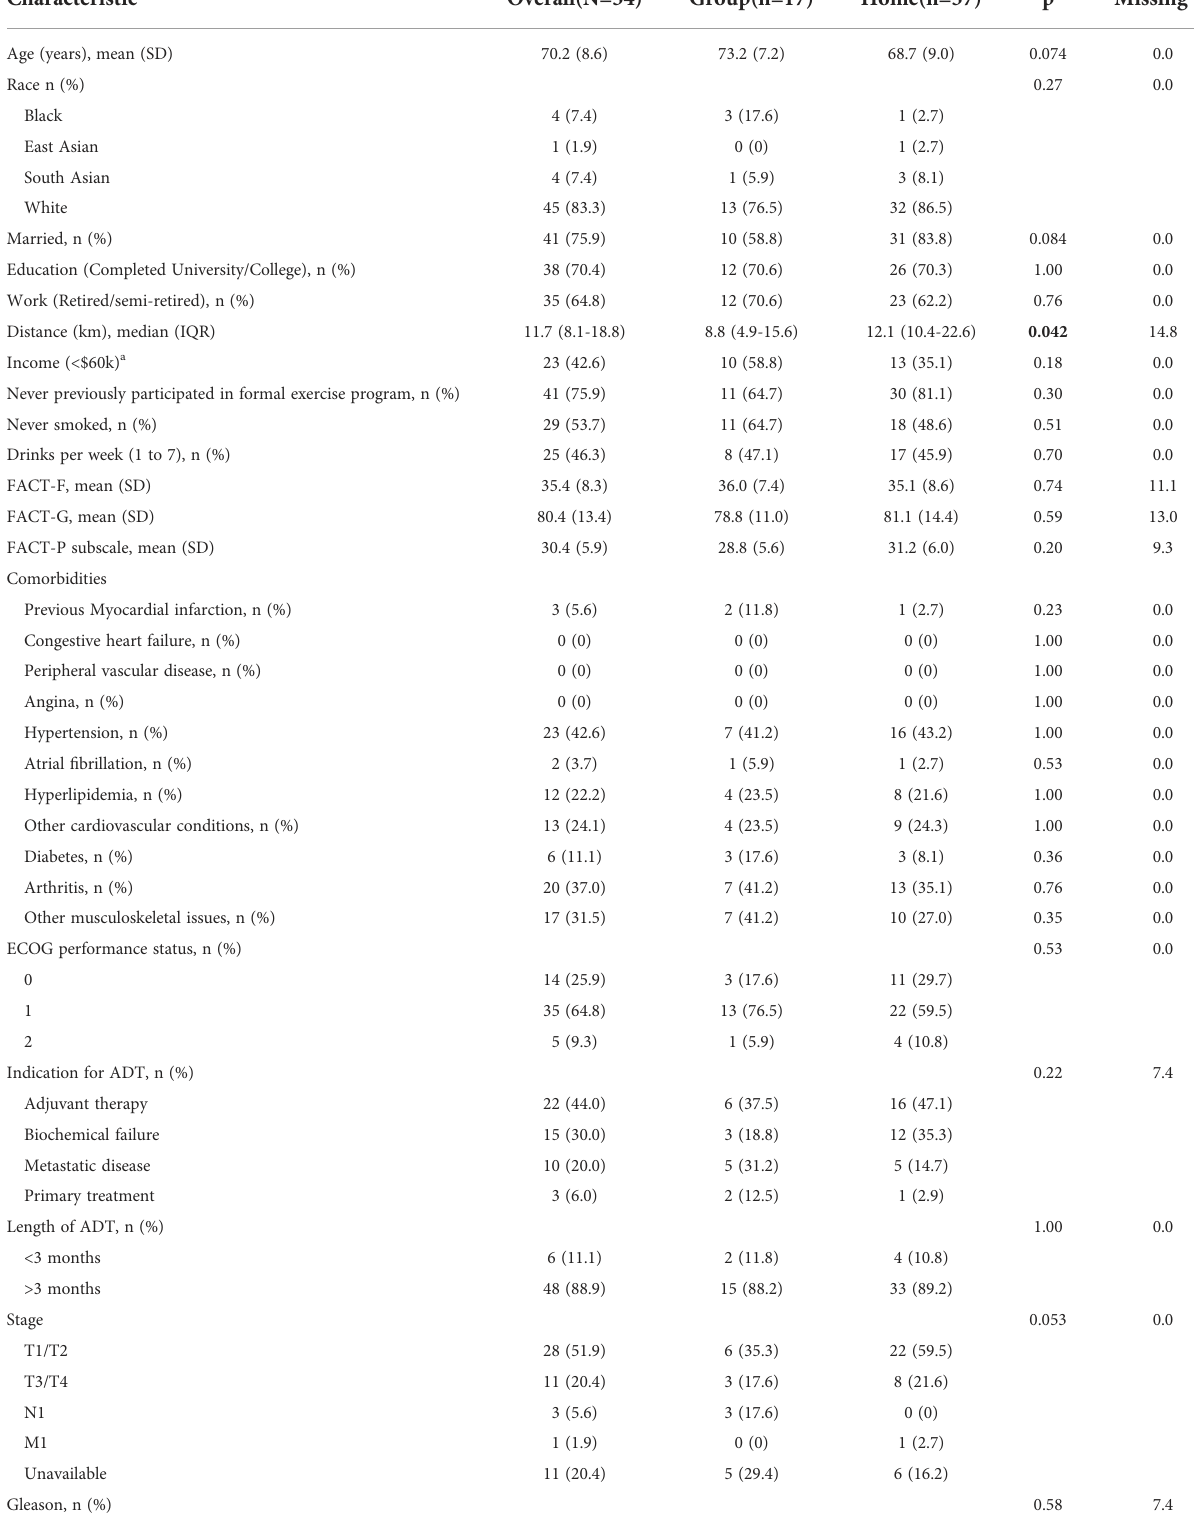
TABLE 3 Characteristics of participants in the preference trial at